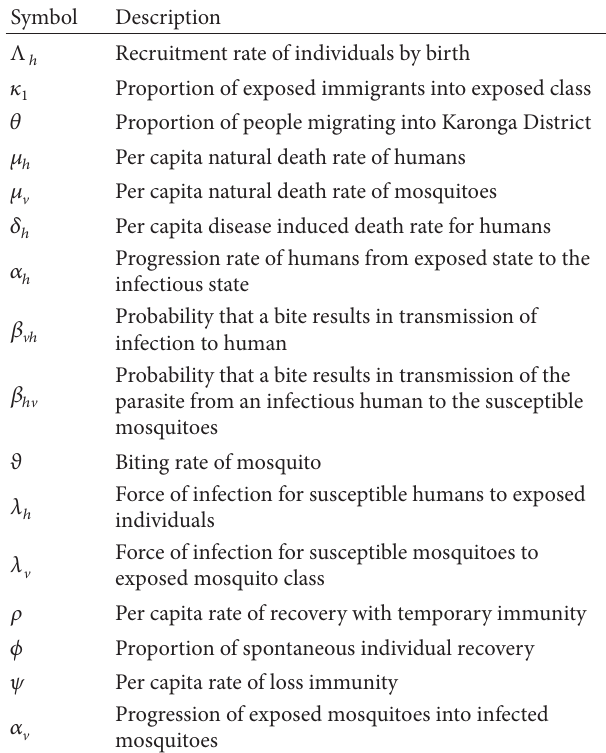
Table 3: Parameters variables of the malaria